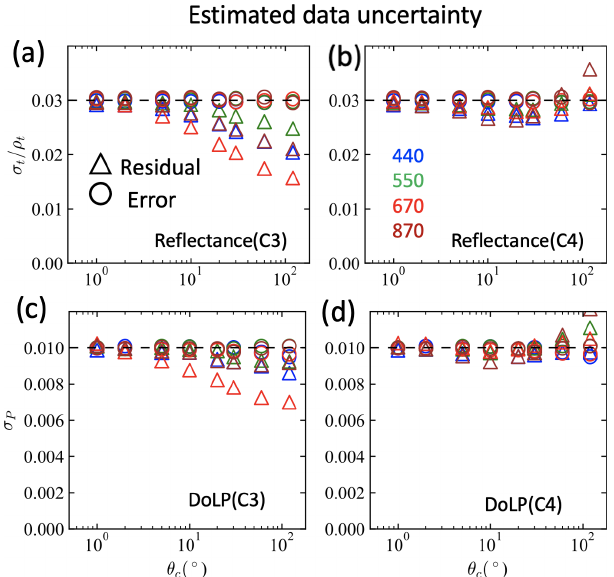
Figure 11. The standard deviation of simulated measurement errors and fitting residual for cases C3 and C4. The model uncertainty of 3% for reflectance and 0.01 for DoLP are indicated by dashed lines. Results of scenarios C1 and C2 for reflectance are similar, but with estimated DoLP uncertainties closer to the 0.01